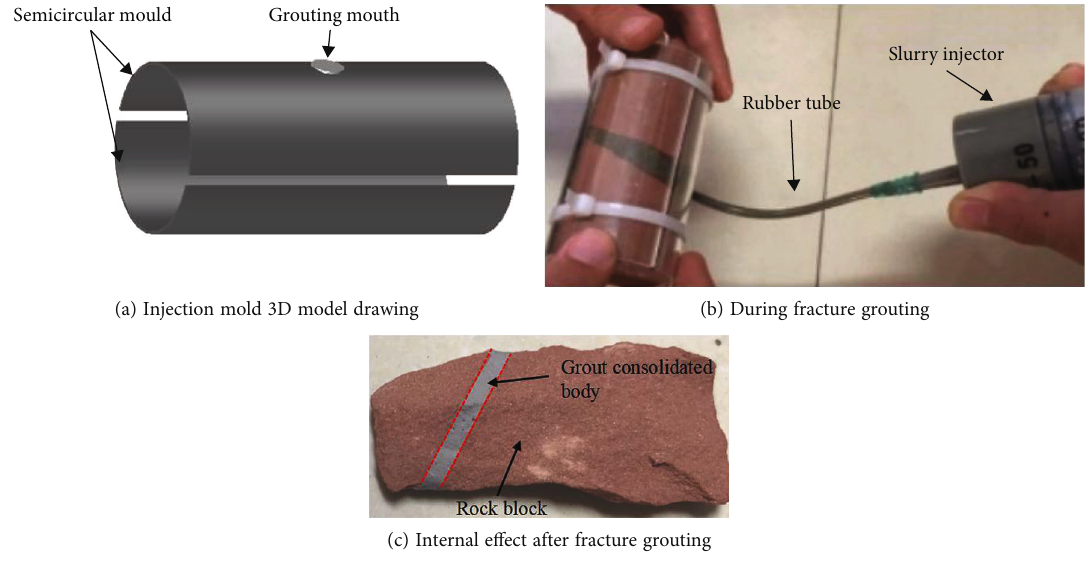
Figure 2: Indoor grouting process and e ff ect of standard fractured